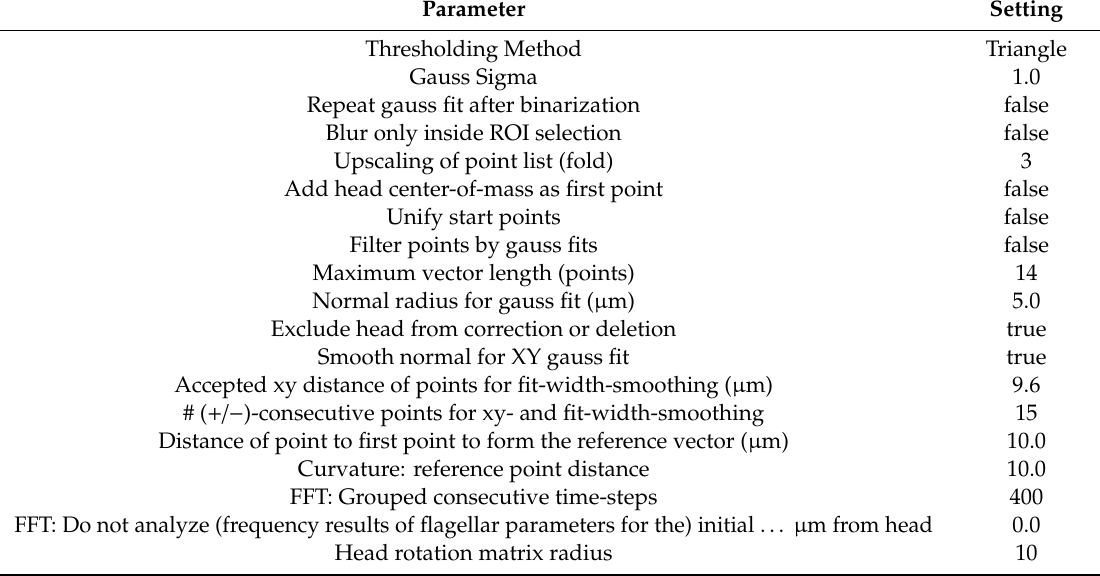
Table 1. SpermQ settings.